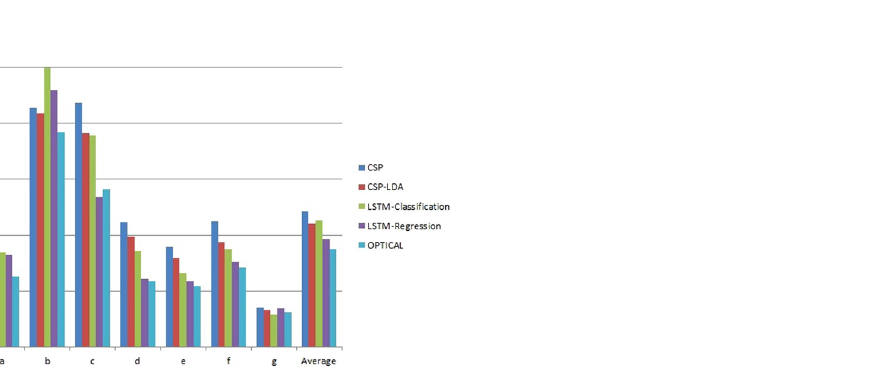
Figure 7. The misclassification rates of different experiments conducted using BCI competition IV dataset